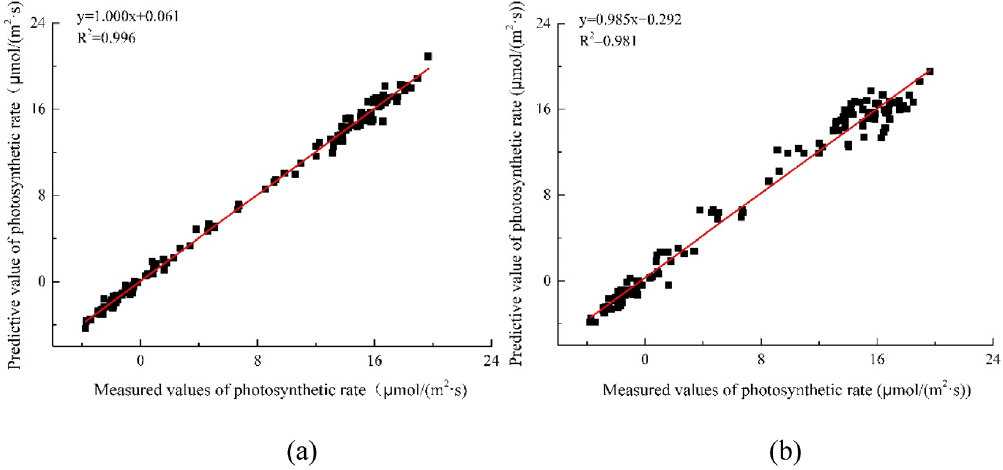
Figure 6. Correlation between the predicted and the measured values of photosynthetic rate. ( a ) Light quality added as input; ( b ) Without light quality as input. The red line is a linear fitting to the